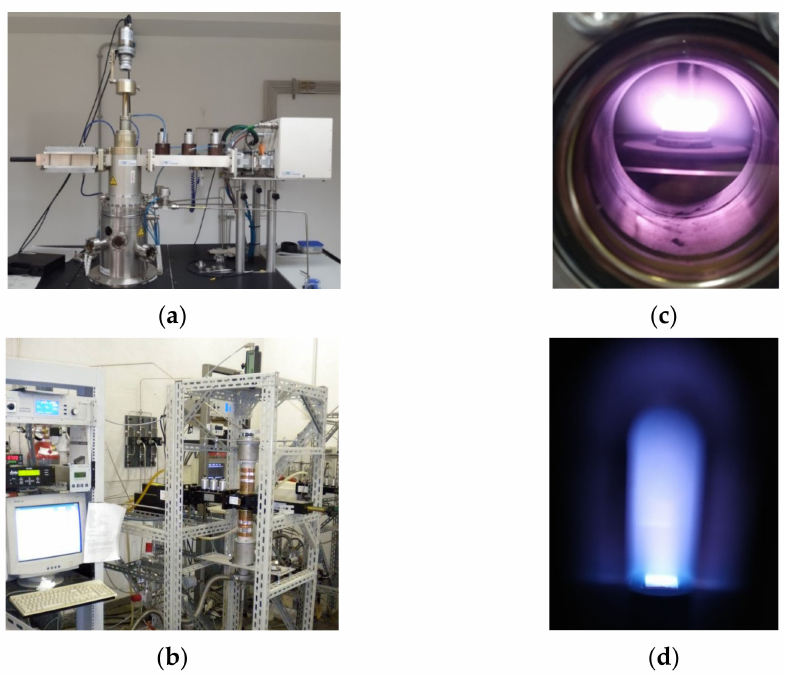
Figure 3. ( a ) Picture of a MWPECVD deposition system operating at ENEA C.R. Frascati (Italy) and ( b ) at University of Rome “Tor Vergata” (Italy); ( c , d ) picture the diamond deposition on the growing substrate located inside vacuum chamber ( a , b ),